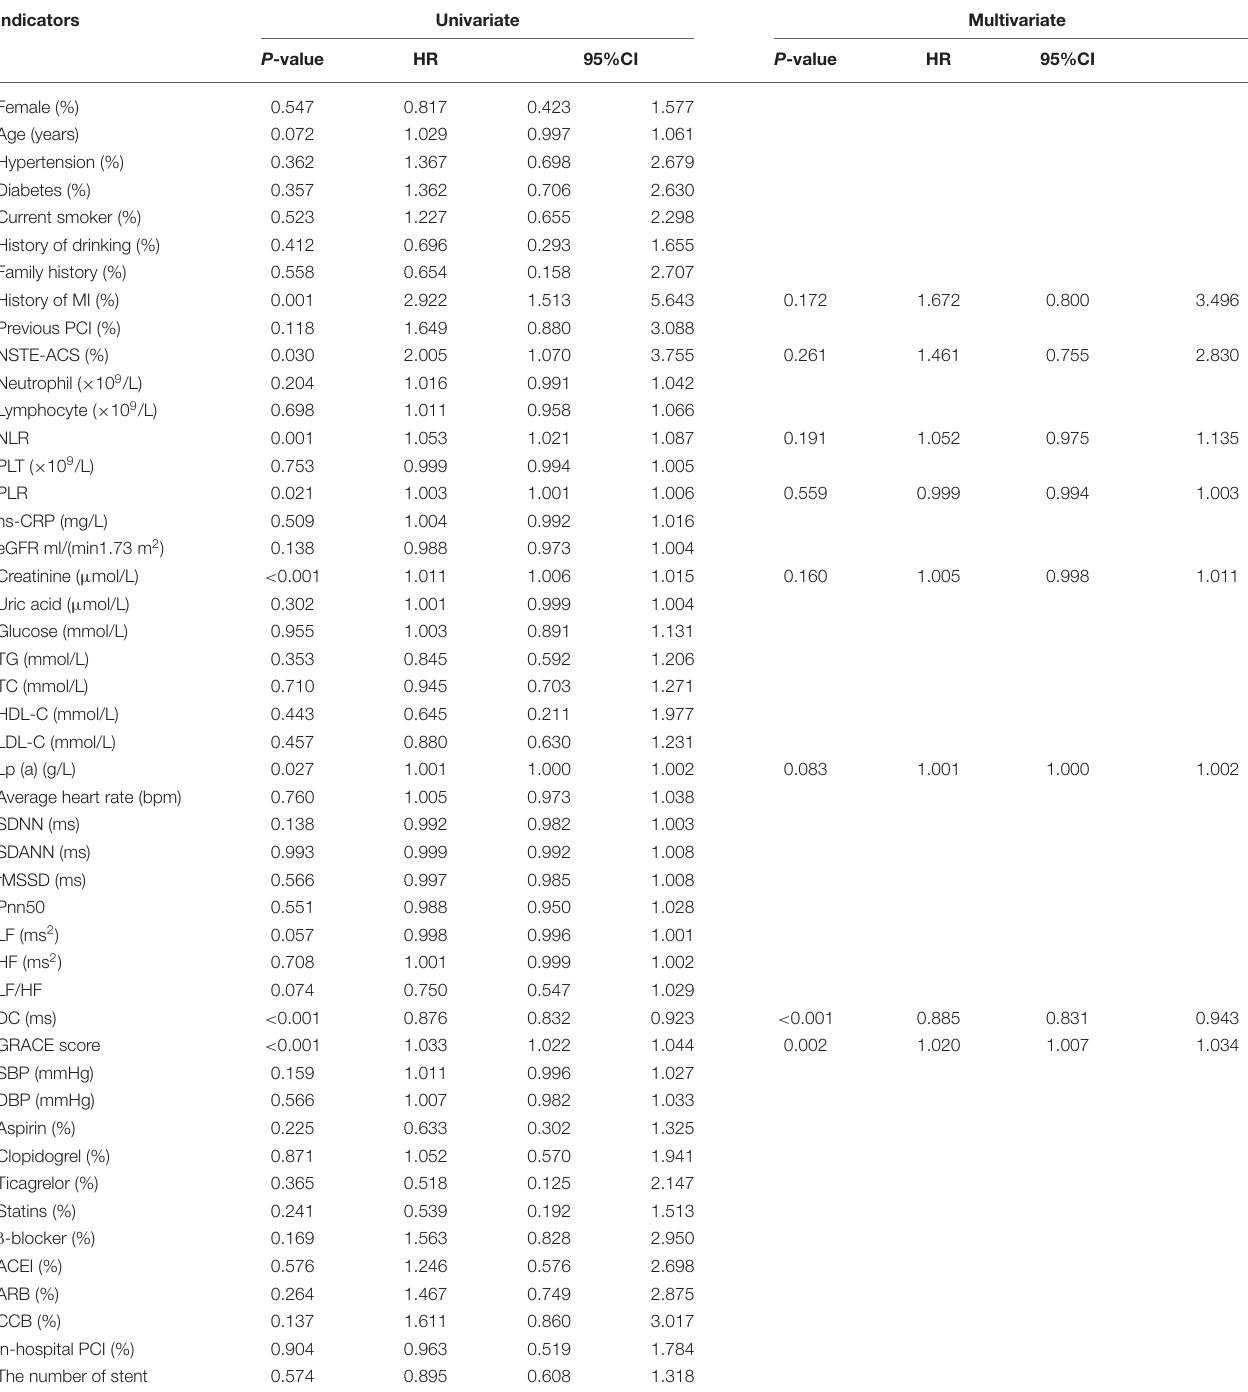
TABLE 2 | Predictors of the occurrence of major adverse cardiovascular events (MACEs) in patients with acute coronary syndrome (ACS): results of univariate and multivariate cox-regression analyses. Indicators Univariate